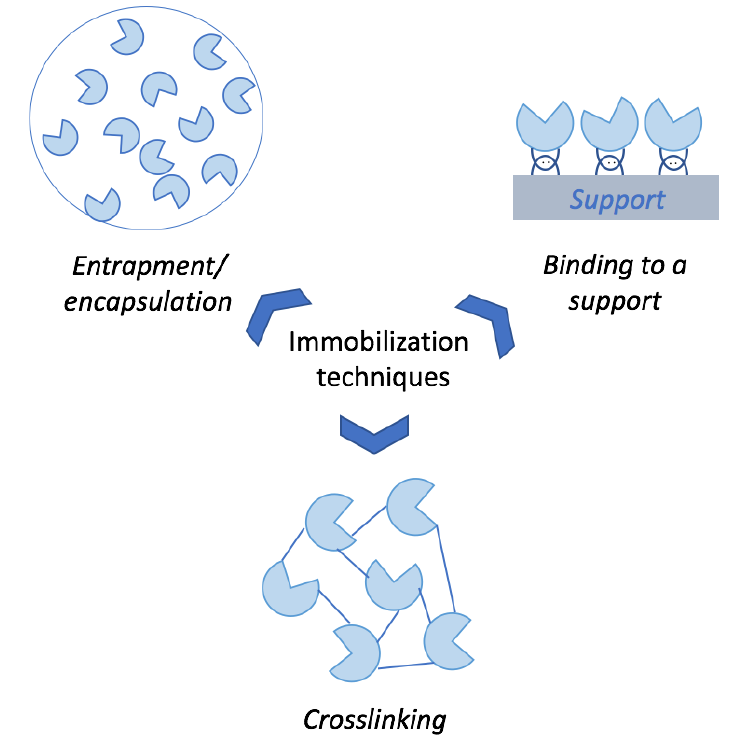
Figure 4. Main techniques employed for enzymes